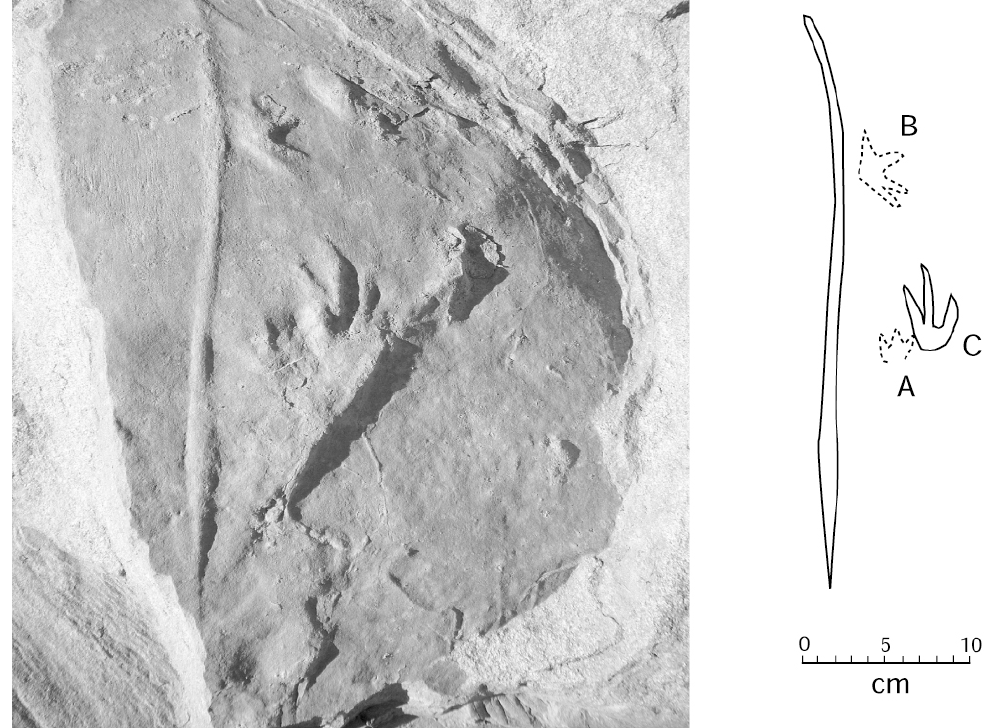
Figure 12. Specimen WWU-TR-074. Prominent drag mark with digitigrades footprints. A , B . right manus; C . right pes.